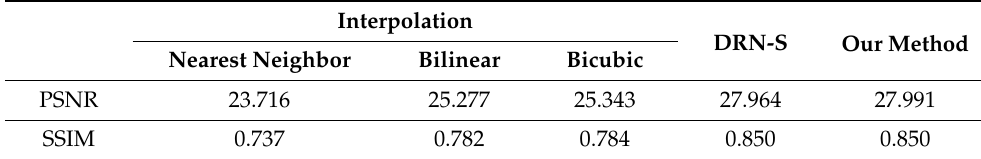
Table 2. The results achieved by different methods.